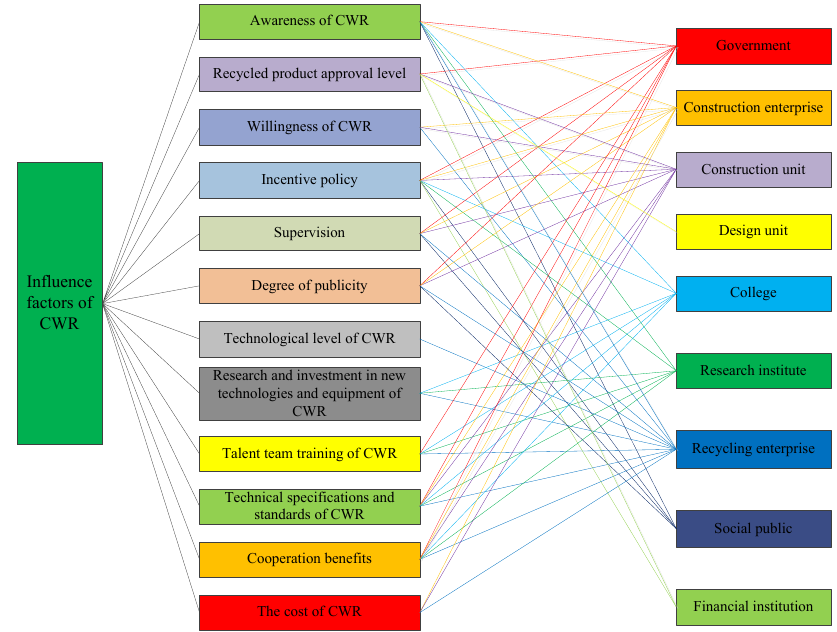
Figure 1. Identification of stakeholders of factors affecting CWR.